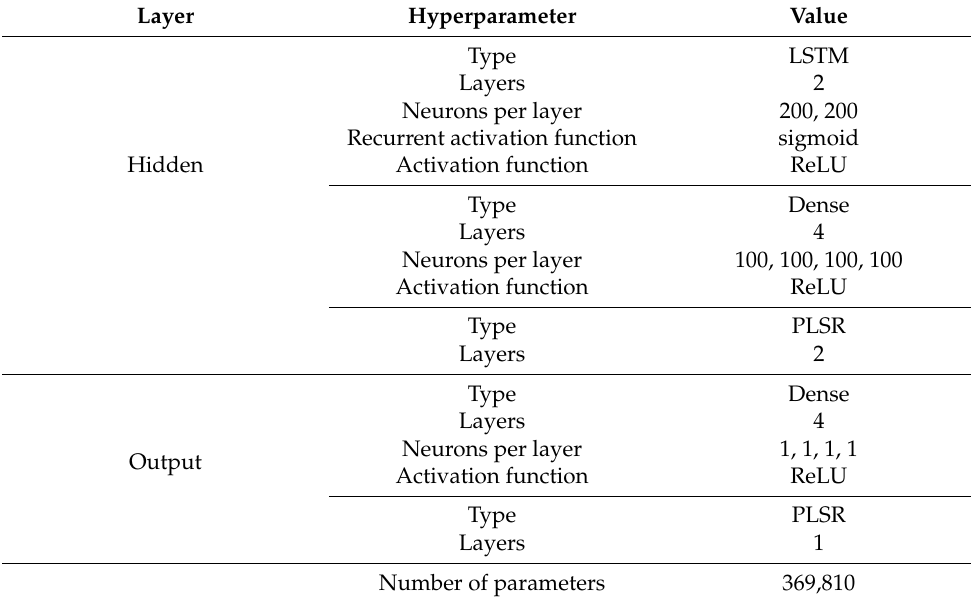
Table 10. Khadem’s architecture hyperparameters